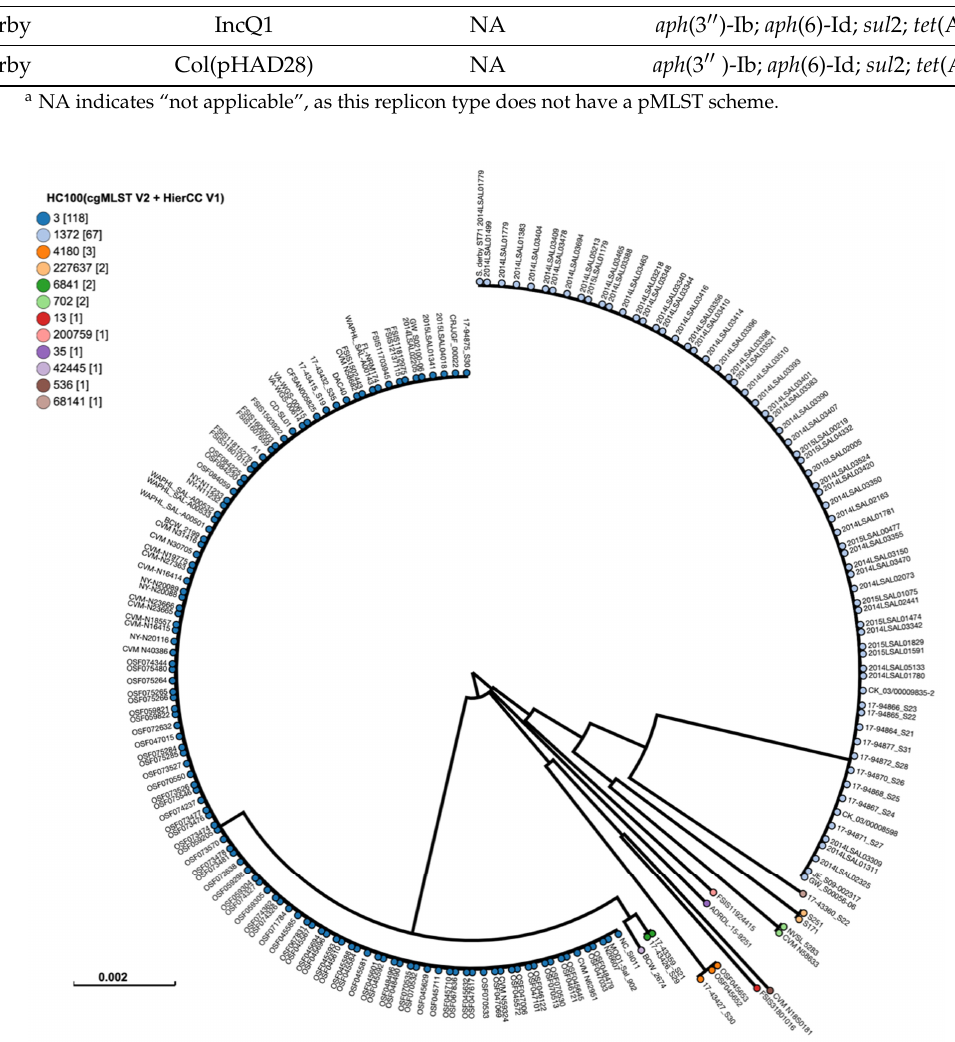
Figure 3. Phylogenetic analysis of the examined S. Derby isolates containing fos A7 ( n = 2) and publicly available S . Derby isolates from chicken in Enterobase (https://enterobase.warwick.ac.uk/ accessed on 1 June 2022) using single-nucleotide polymorphisms (SNPs) and hierarchical clustering of core genome (cg) MLST (HierCC). The legend shows cgMLST HC100, which indicates allelic dif- ferences of no more than 100 of 2850 core genomic alleles among isolates.